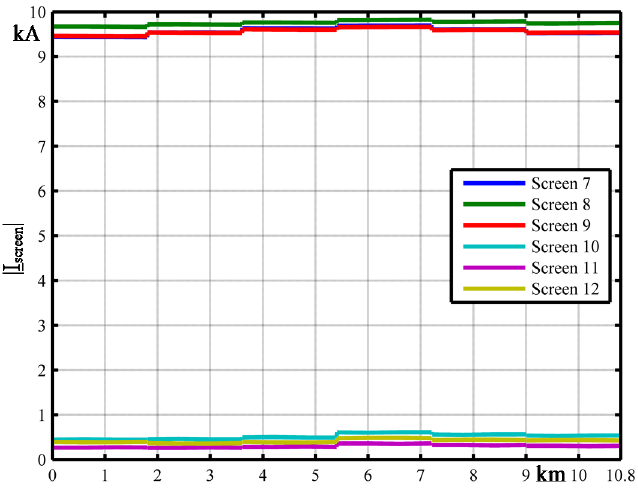
Figure 10. Faulted double-circuit UGC: screen current magnitudes along the line (CB with PTs); FAULT at